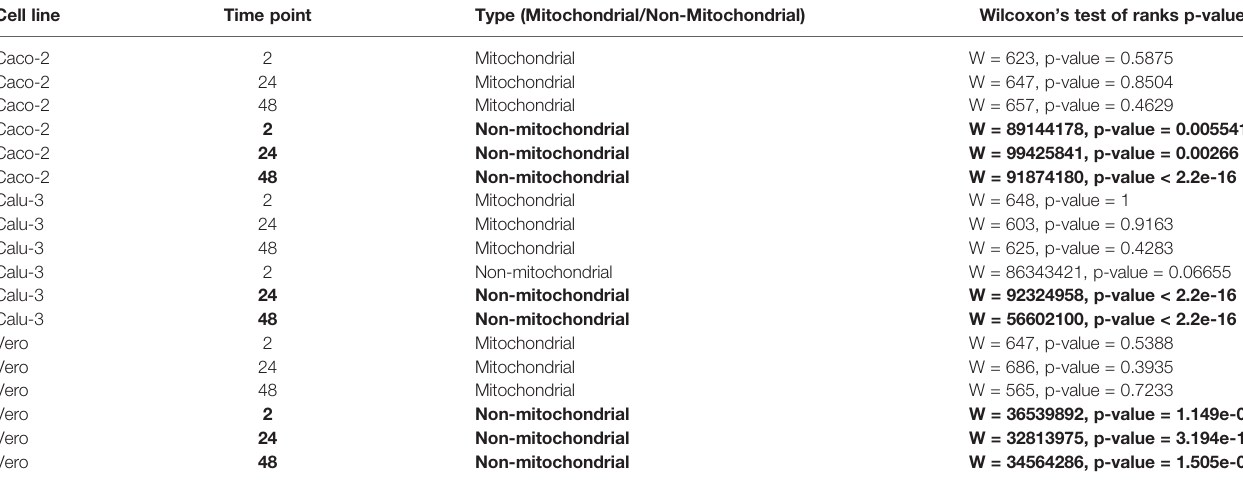
TABLE 4 | Signi fi cance of differential polyadenylation in Caco-2, Calu-3 and Vero cell lines measured by Wilcoxon ’ s test of ranks following nanopolish analysis of direct RNA datasets. Cell